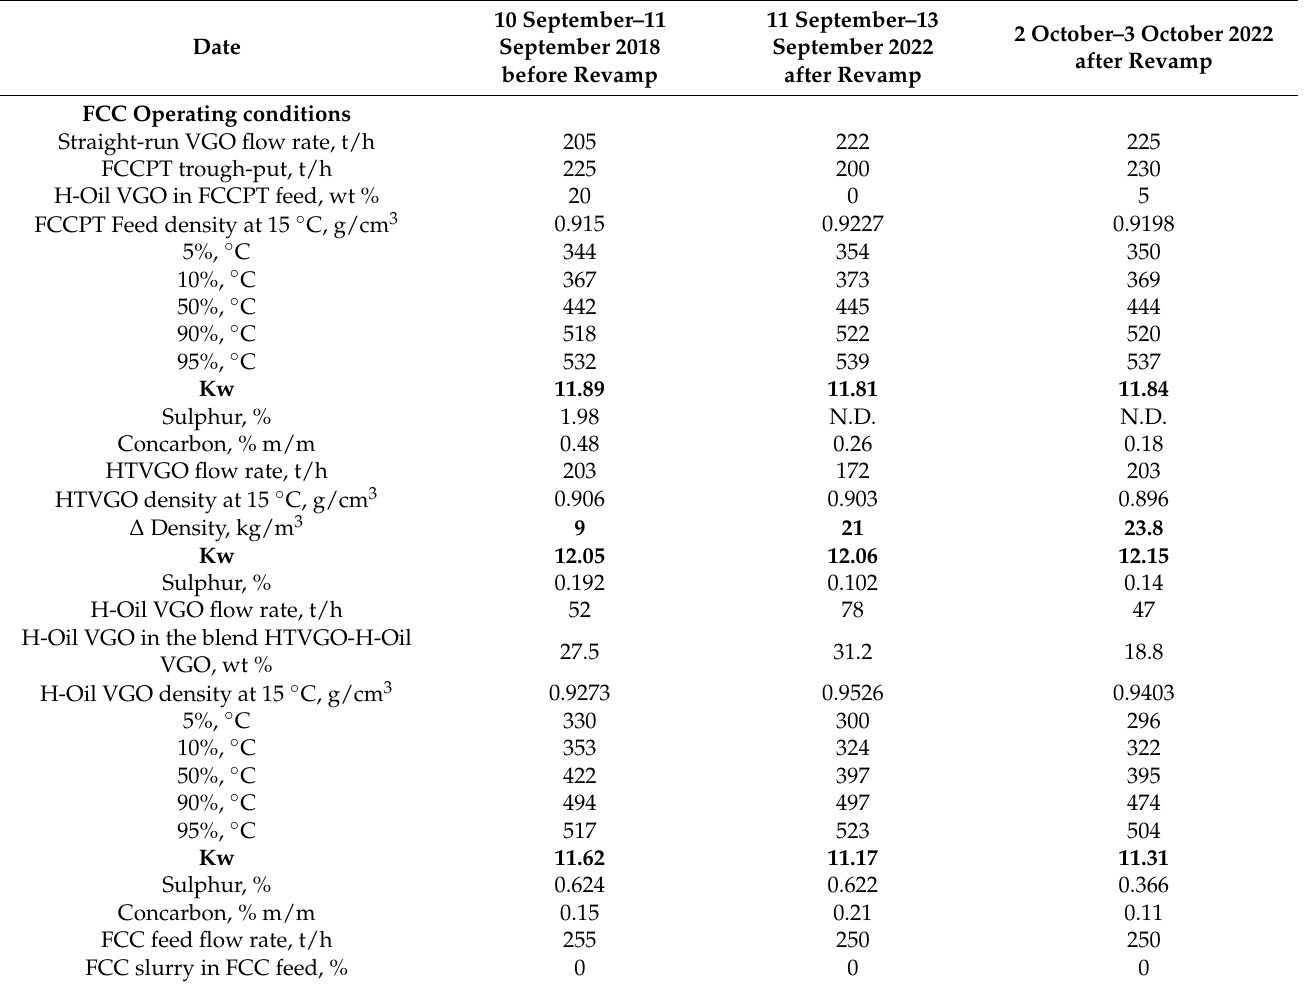
Table 4. LNB FCCU performance before and after the